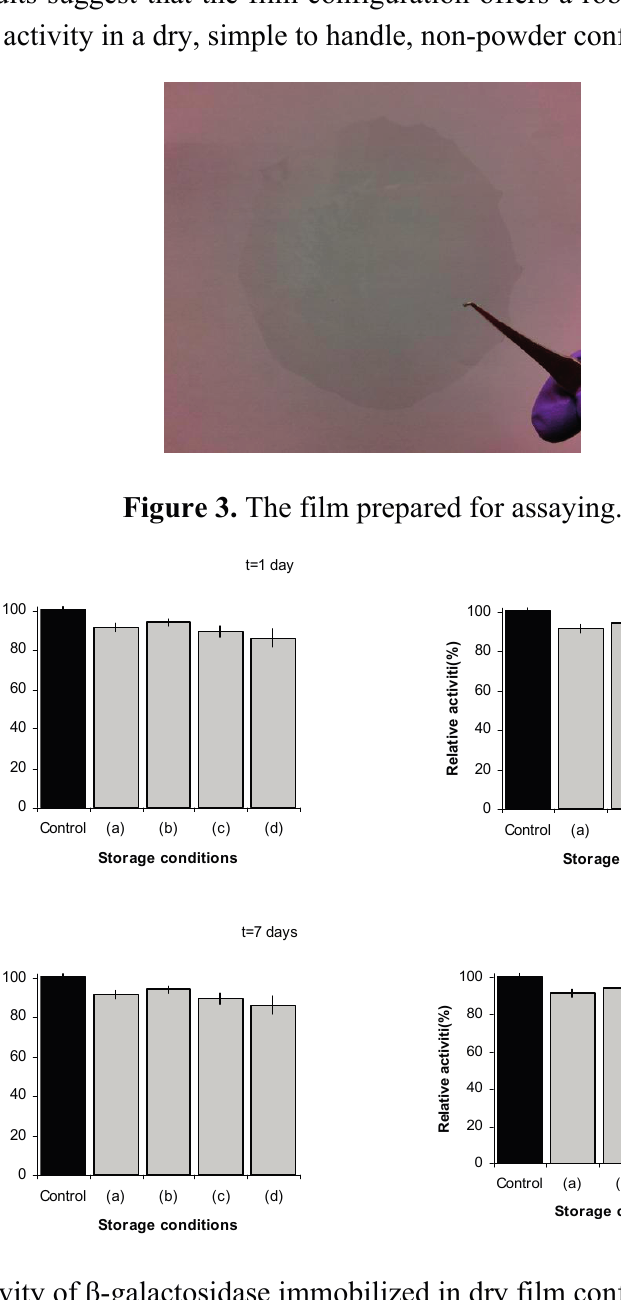
Figure 4. Activity of β -galactosidase immobilized in dry film configuration under different storage conditions. Control: freshly prepared solution. Activity of control solution is used as reference. ( a ) room temperature (23 ± 2 °C)+ 55% RH; ( b ) room temperature and 75% RH; ( c ) 36 °C (dry environment); and ( d ) 36 °C and 75%